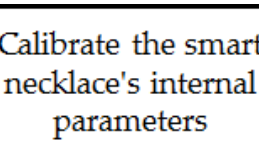
Figure 9. Operating process whereby the notebook computer is used to perform posture recognition.